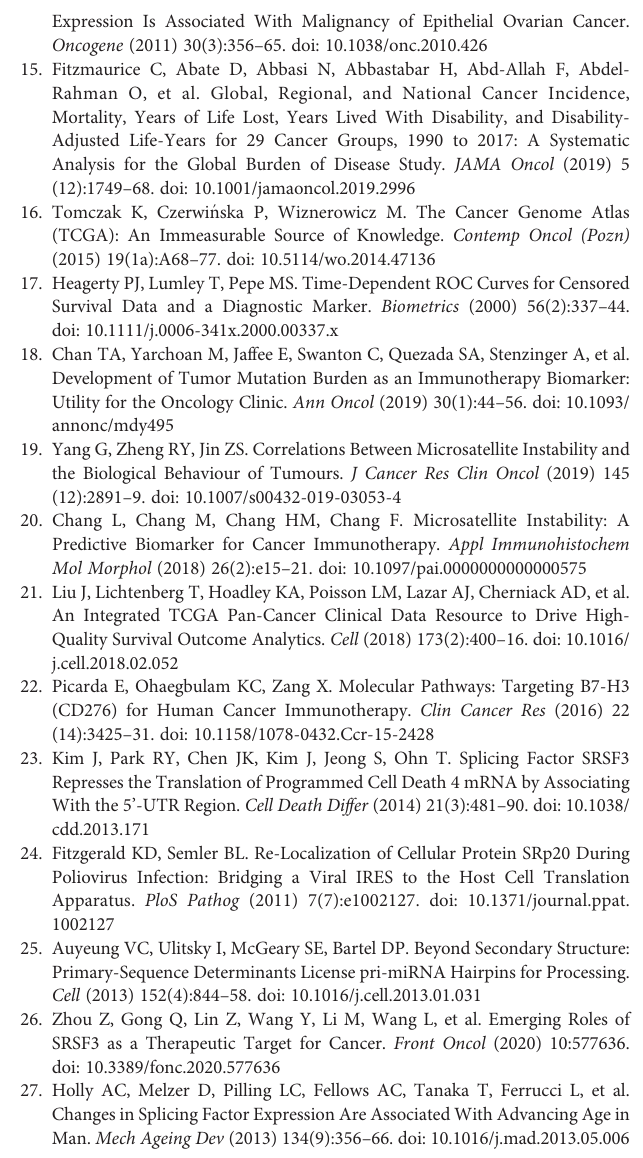
activated/resting, CD8 + T cells, T cells follicular helper, T cells regulatory (Tregs), T cells gamma delta, monocytes, natural killer cells (NK cells), macrophages 0/1/2, neutrophils, eosinophils, mast cells activated/resting and dendritic cells). Supplementary Figure 2 | Relation between TMB, MSI and SRSF3 expression levels in different tumors from TCGA database. (A) Correlation between TMB and SRSF3expression. (B) CorrelationbetweenMSIandSRSF3expression.Spearman correlation test was conducted and P < 0.05 is considered to be statistically signi fi cant. (C) Correlation between SRSF3 expression levels and recognized immune checkpoints ’ expression in different tumors from TCGA database. The underlying triangle in each tile represents coef fi cients calculated through Pearson ’ s correlation test, and the upper triangle represents log10 transformed P -value. * P < 0.05, ** P < 0.01, *** P < 0.001. Supplementary Figure 3 | Functional and pathway enrichment analysis. (A) KEGG pathways; (B) GO